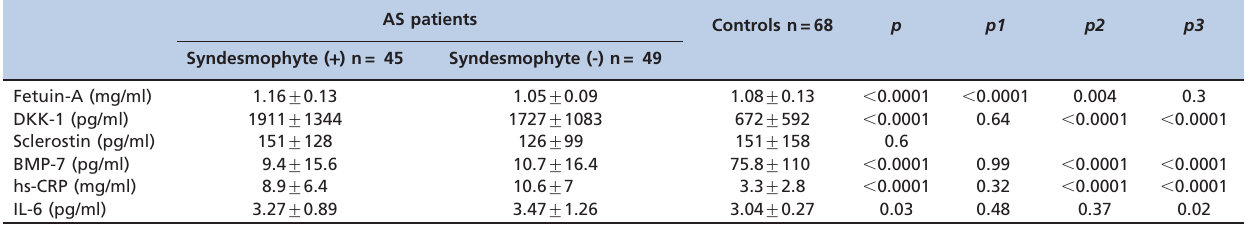
Table 2 - Laboratory characteristics of the study group.